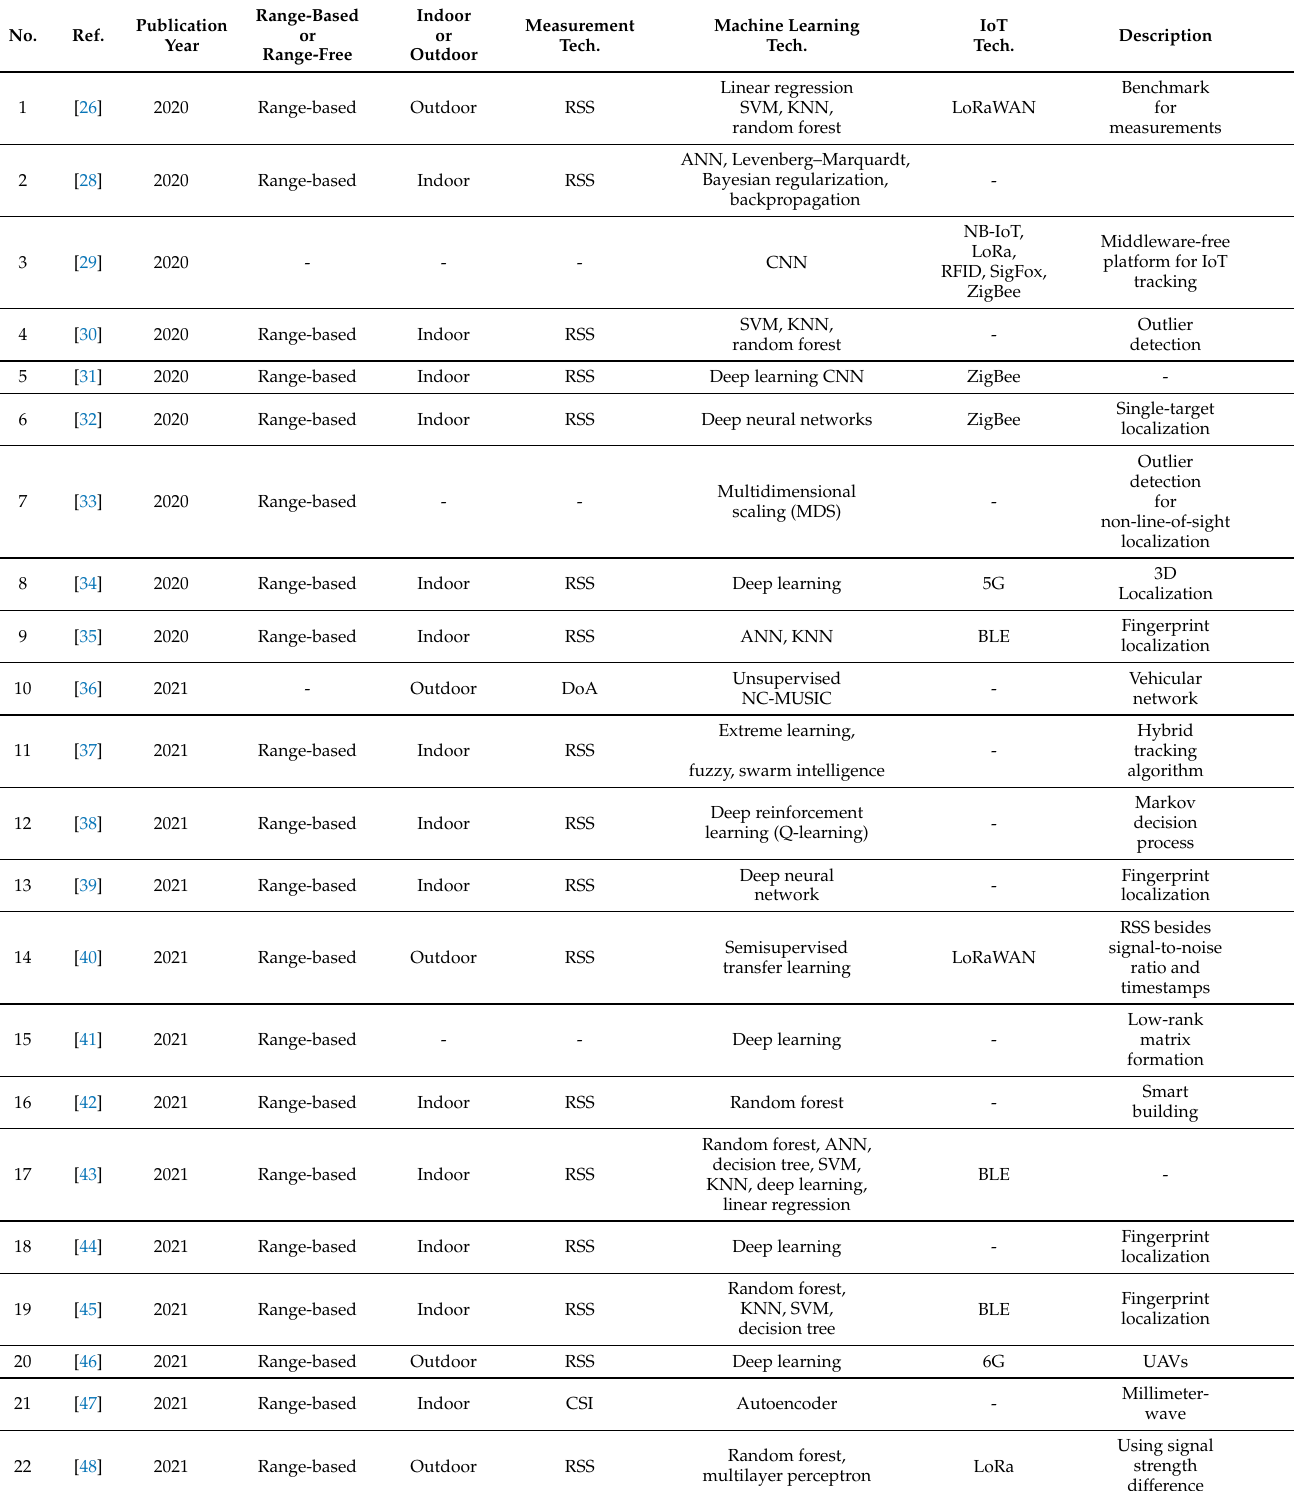
Table 2. Summary of the related studies reviewed in this paper [2020 to 2022]. “-” means that the feature is not clearly addressed in the paper, for instance, when it is not mentioned that it has specific application in indoor or outdoor